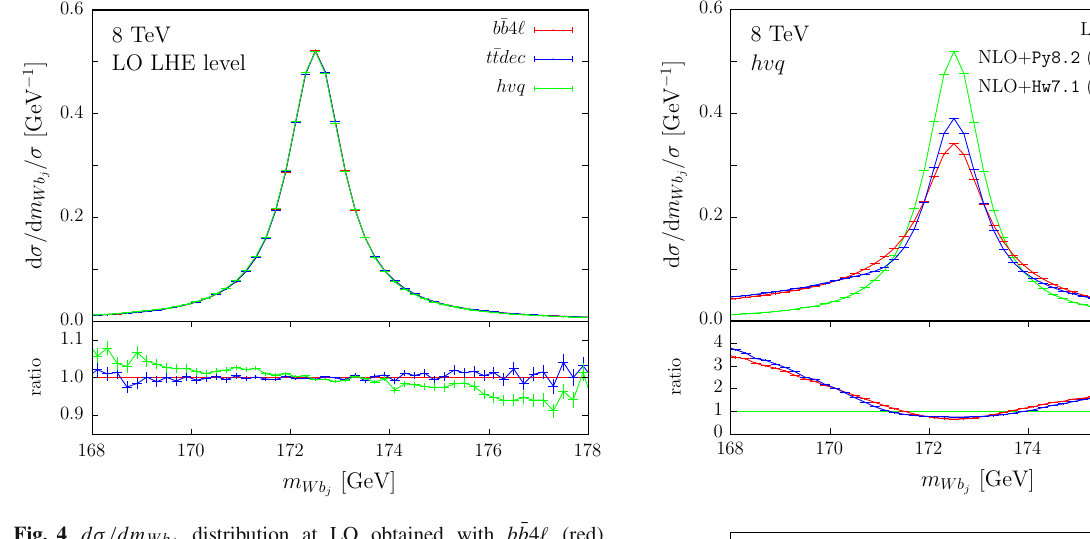
Fig. 4 d σ/ dm Wb distribution at LO obtained with b ¯ b 4 (cid:4) (red), j t ¯ tdec (blue) and h v q (green), normalized to 1 in the displayed range. In the bottom panel the ratio with the b ¯ b 4 (cid:4) prediction is shown